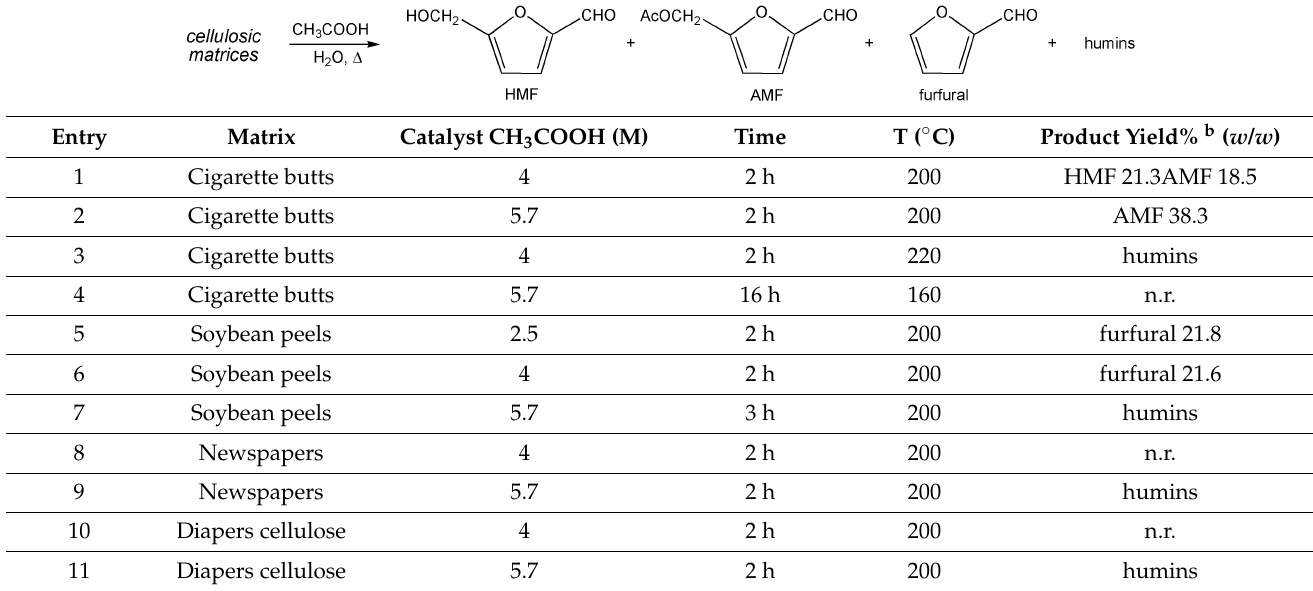
Table 4. Thermal conversion into HMF, AMF, and furfural catalyzed by acetic acid a .